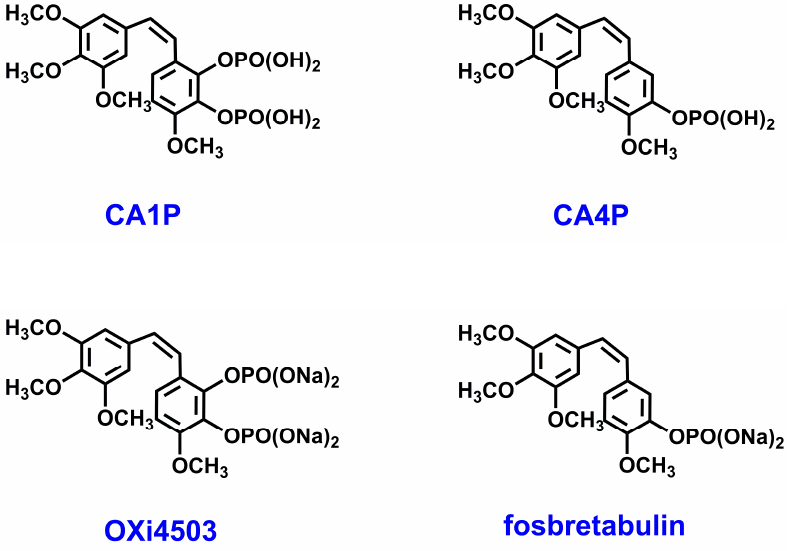
Figure 1. Structure of natural stilbenoids with anti-cancer activity: combretastatin CA1 and CA4 phosphate ( CA1P and CA4P , respectively), as well as their disodium salts ( OXi4503 and fosbretabulin , respectively).